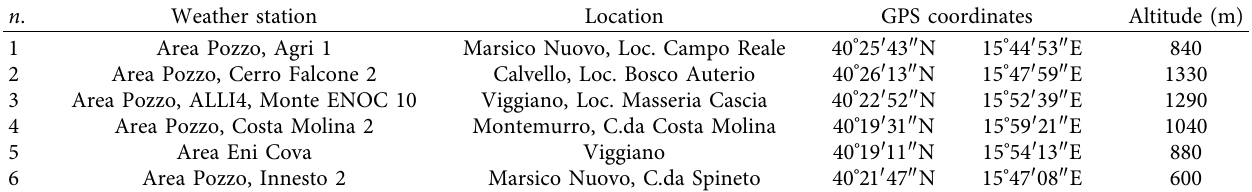
Table 1: Geographical positions and altitudes of the six weather stations installed in the Val d’Agri area and used in the analysis of the model performance. n